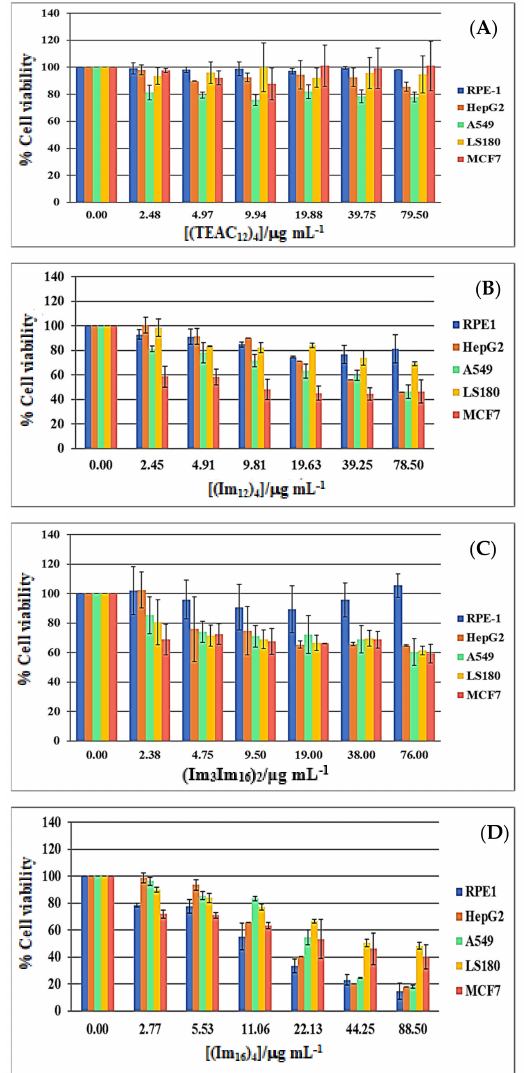
Figure 2. Cell viability values in the presence of different liposome concentrations at α = 0.5 for (TEAC 12 ) 4, (Im 12 ) 4 , and (Im 3 Im 16 ) 2 , and at α = 0.3 for (Im 16) ) 4. The results are the average of three independent experiments: ( A ) (TEAC 12 ) 4 ; ( B ) (Im 12 ) 4 ; ( C ) (Im 3 Im 16 ) 2 ; ( D ) (Im 16 ) 4